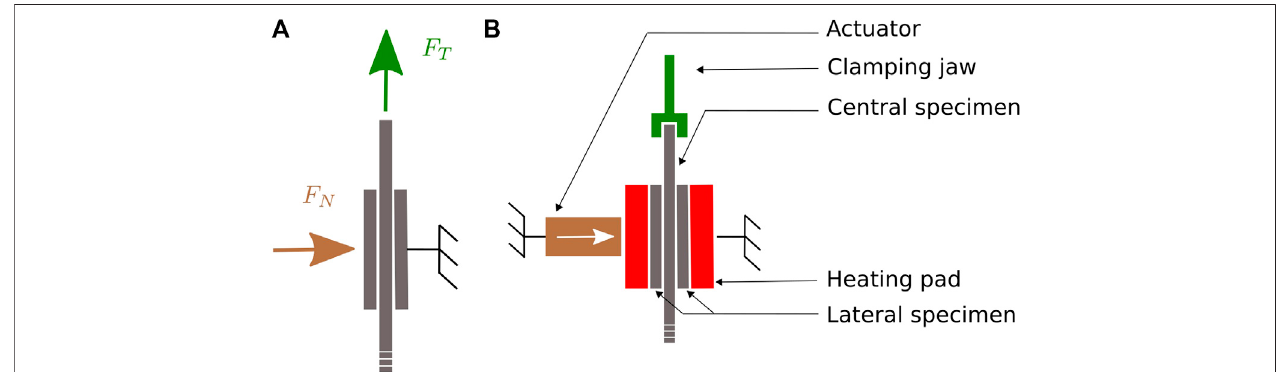
FIGURE 5 | (A) Principle of the pull-through test and (B) schematic of the inter-ply friction characterization